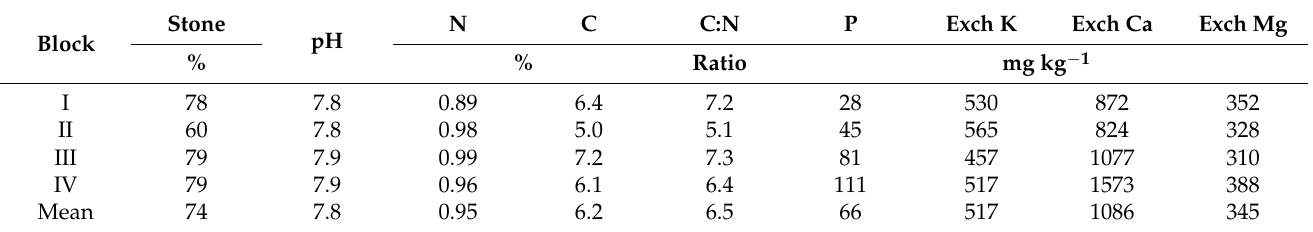
Table 1. Physical and chemical characteristics of the experimental area (mean values by